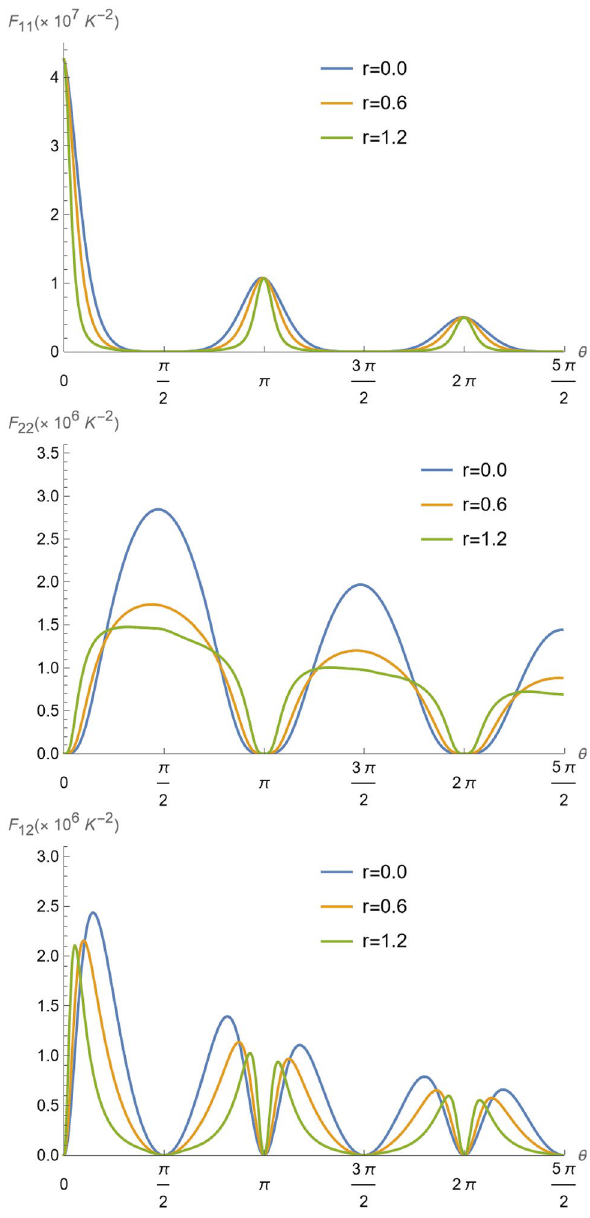
Figure 8. Fisher information F 11 , F 22 and F 12 as a function of parameter θ = gt for ¯ n 1 = 0.35 4 K 4 K ( T 1 = 1.42 × 10 − ), ¯ n 2 = 2.3 ( T 2 = 5.32 × 10 − ), �/ 2 π = 4 MHz, g /π = 3.1 kHz, and a heating rate Ŵ = 1.885 quanta per milisecond ( Ŵ/ g = 0.1936 ) 37,57